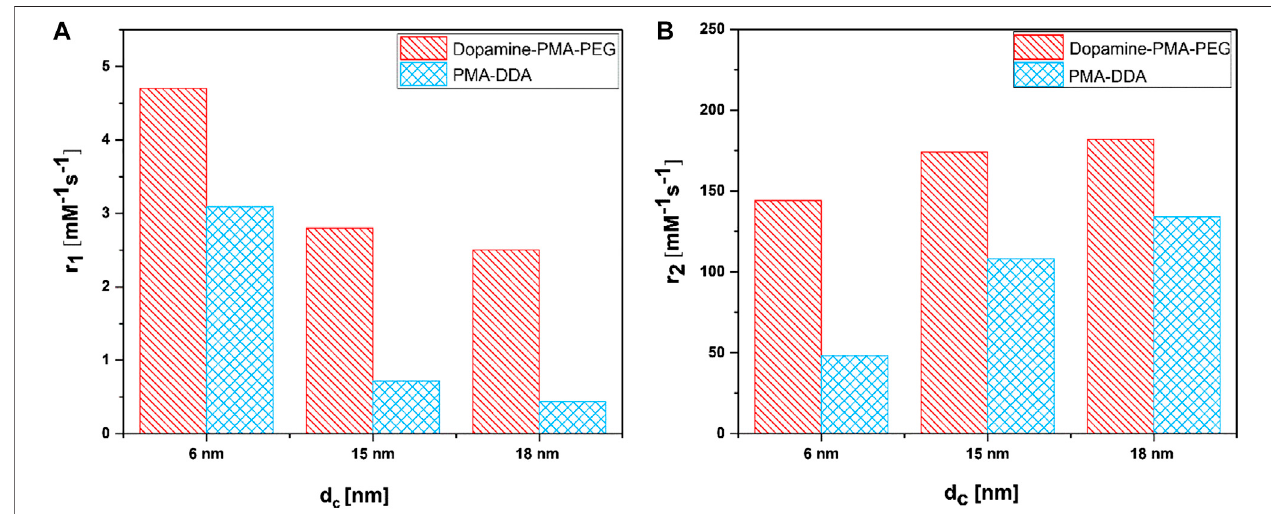
FIGURE 7 | (A) Longitudinal relaxivity (r 1 ) and (B) transverse relaxivity (r 2 ) as a function of polymer coating and particle size d c of